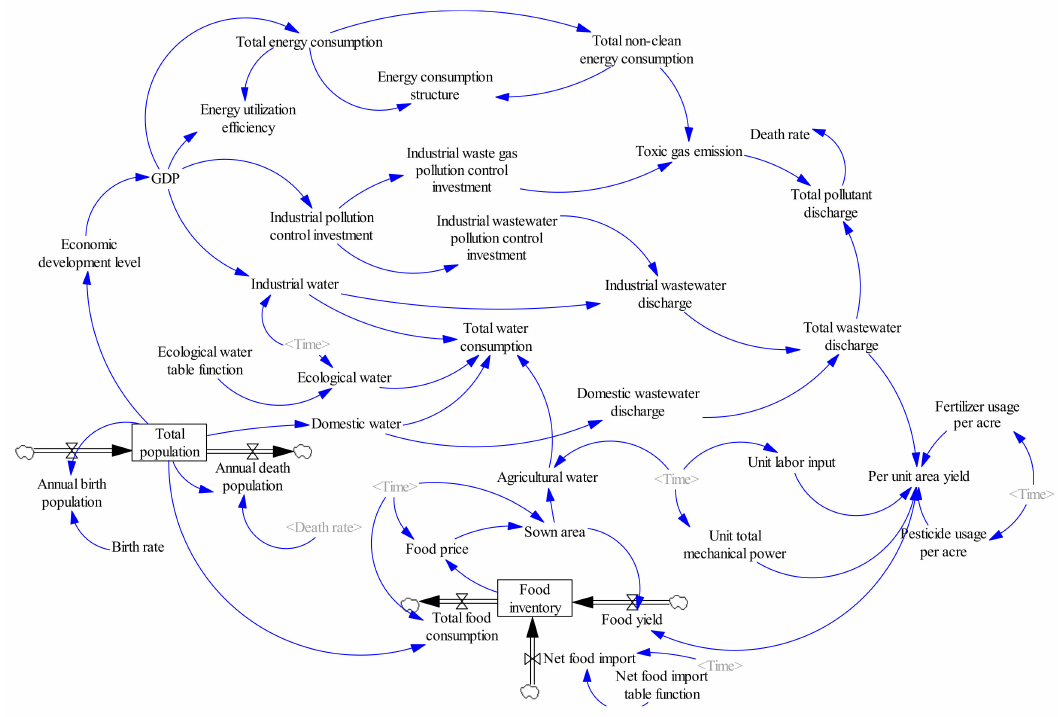
Figure 5. Stock-flow chart of China’s water-energy-food